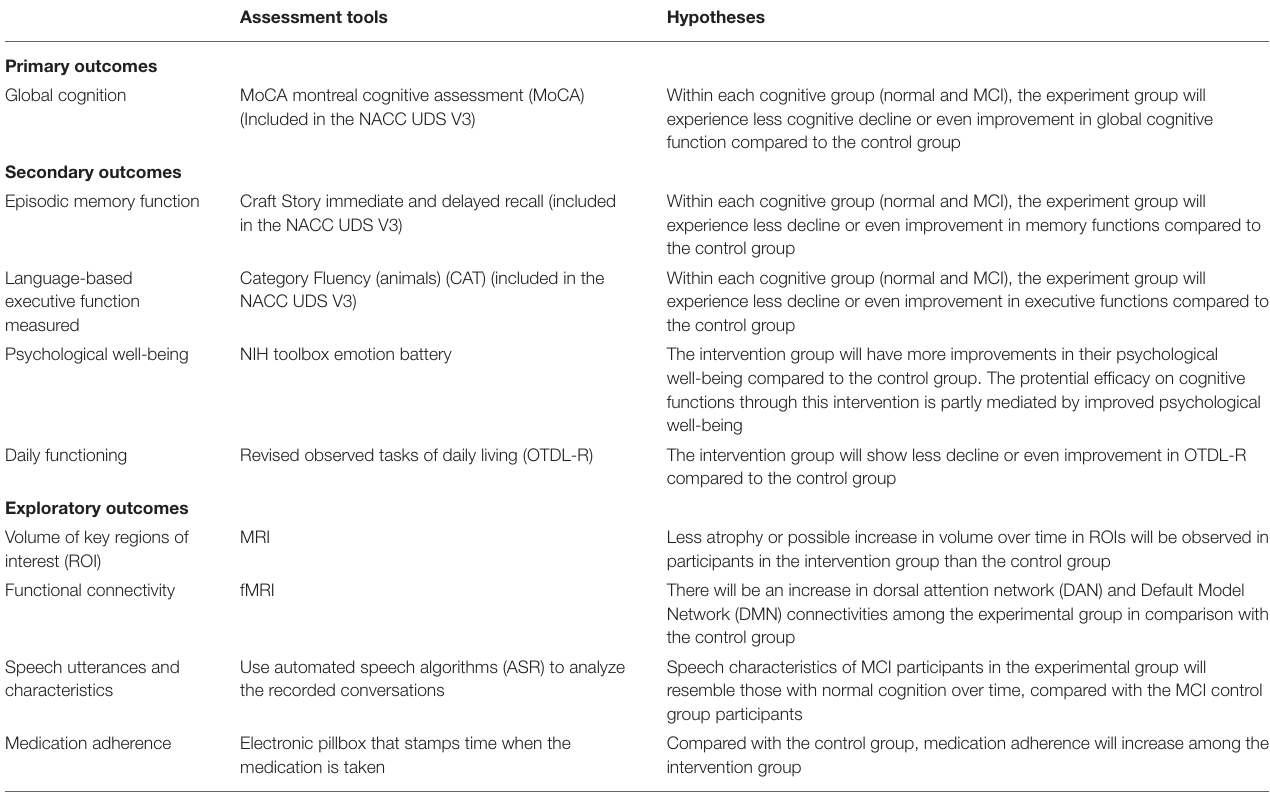
TABLE 2 | Summary of the outcomes, the assessment tools and specific